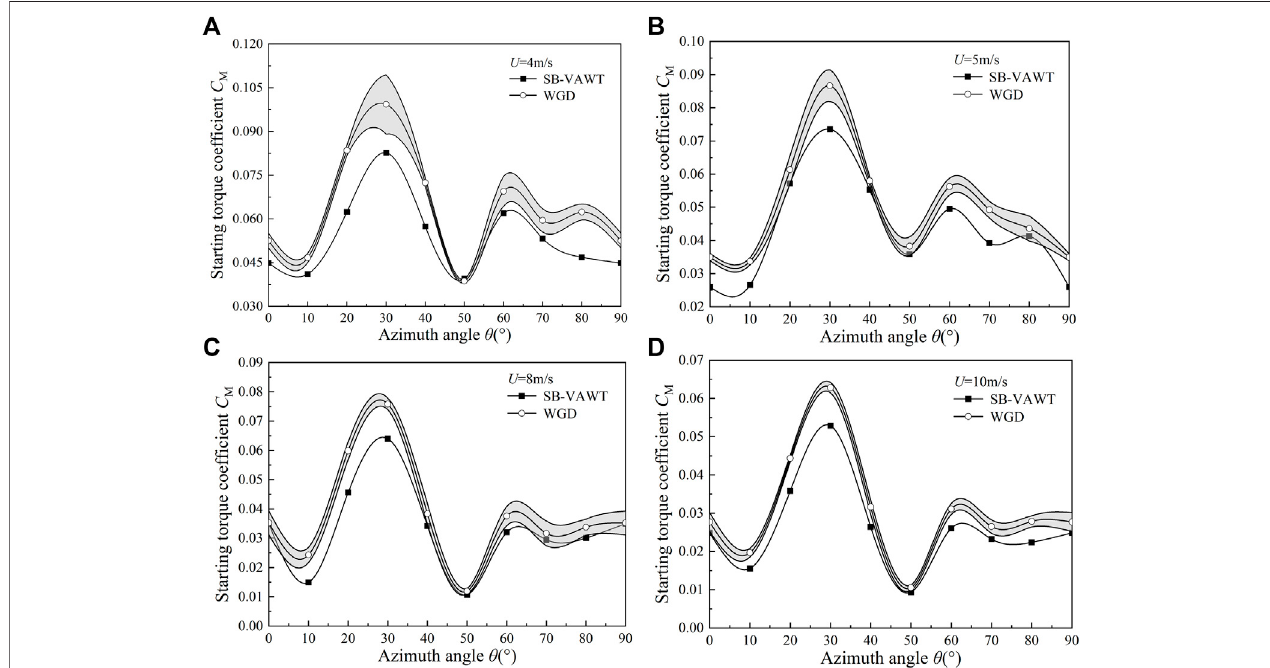
FIGURE 6 | Static torque coef fi cients of the rotor with and without the WGD by wind tunnel tests.